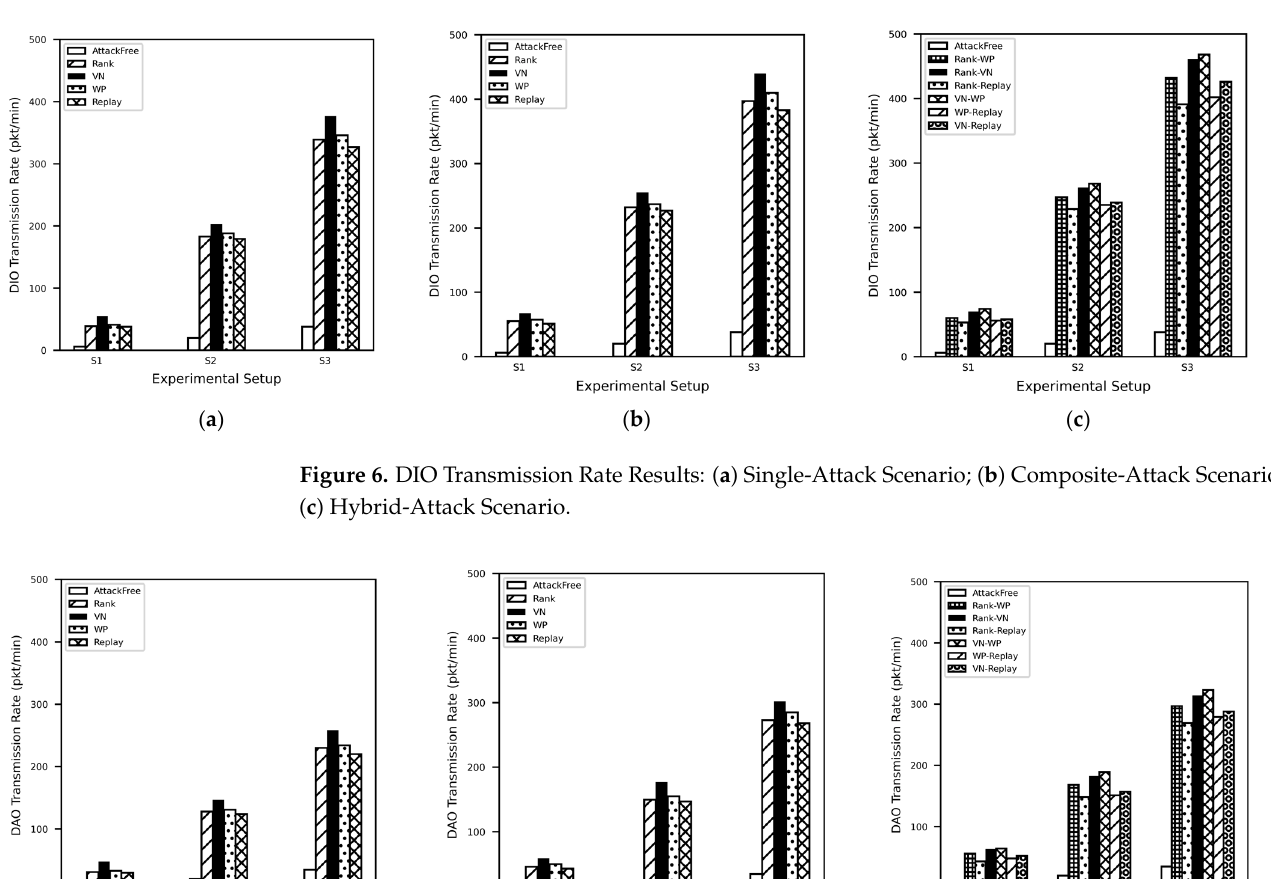
Figure 5. Average Beacon Interval Results: ( a ) Single-Attack Scenario; ( b ) Composite-Attack Scenario; ( c ) Hybrid-Attack Scenario.